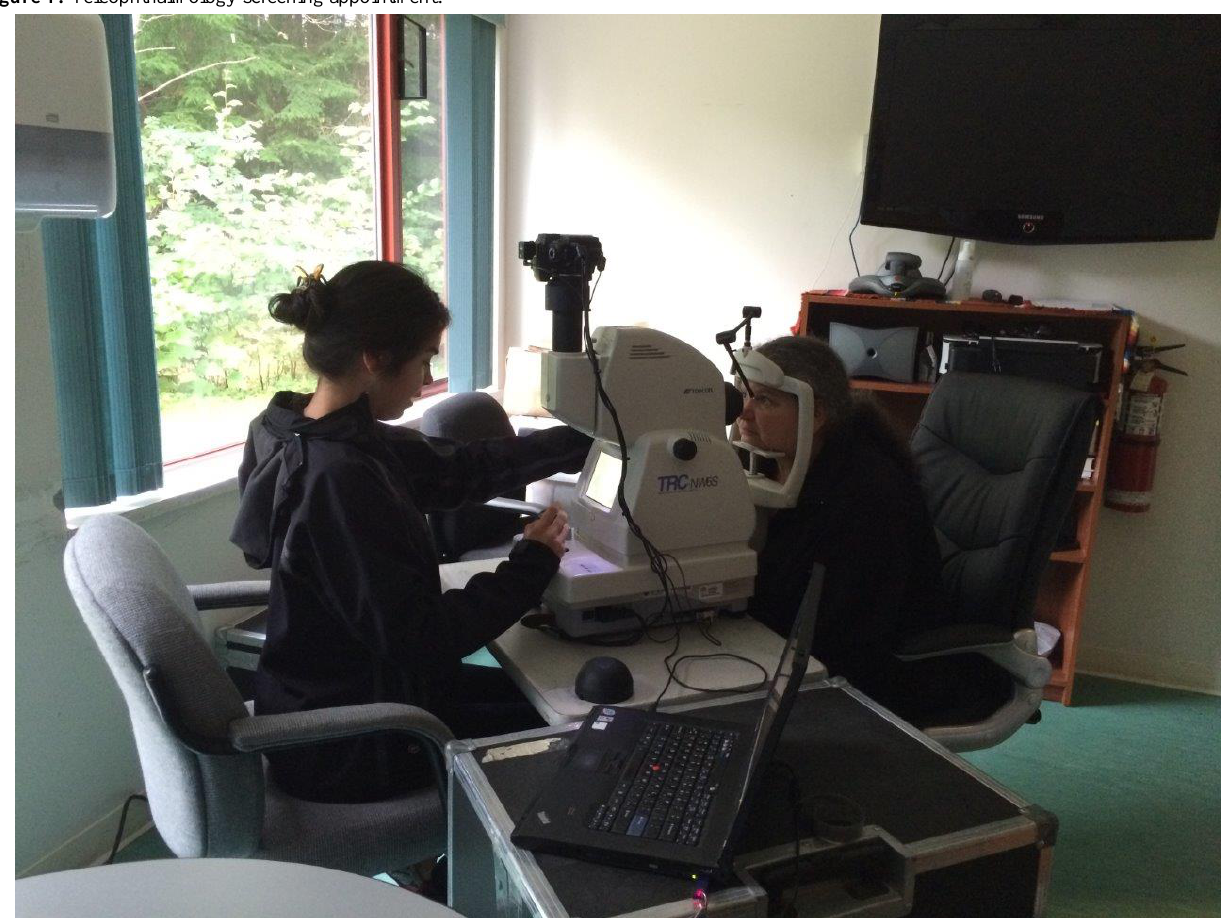
Figure 1. Teleophthalmology screening